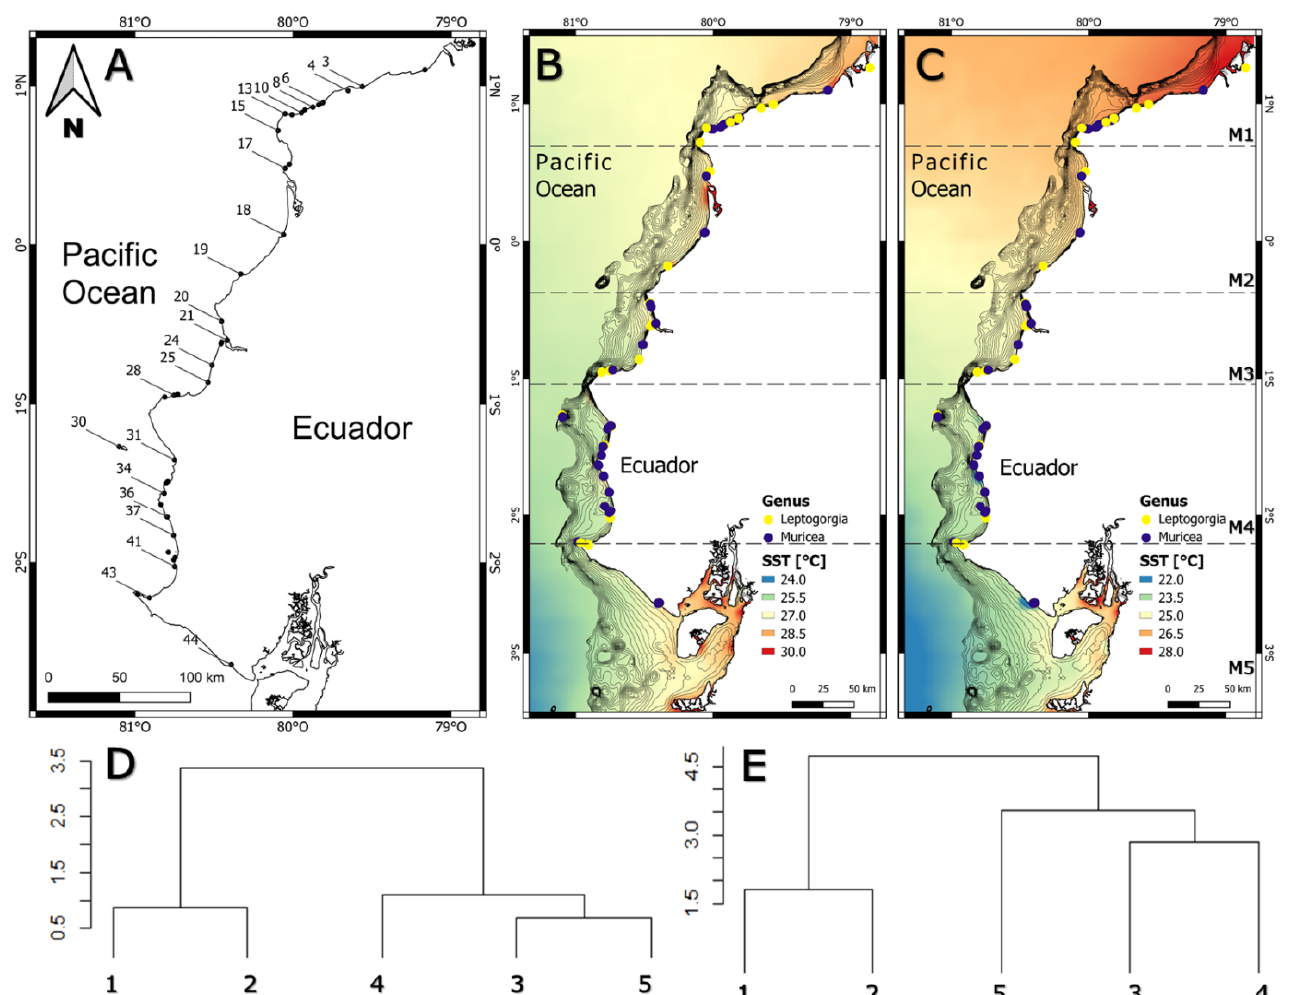
Figure 1. ( A ) Map of the Ecuadorian continental coast showing the 44 octocoral samples sites with black dots, including the Marine Protected Areas located in four coastal provinces of Ecuador. Sea Surface Temperature (SST) is in Celsius degrees (°C), and bathymetry maps are represented in a color scale from colder (blue) to hotter (red) temperature variations during both weather seasons. ( B ) Wet season (December–May). ( C ) Dry season (June–November). ( D ) SST Cluster dendrogram determined by macrozones (1–5). ( E ) General Cluster dendrogram determined with all variables (SST, CHL-a, and PAR) by macrozones (1–5). The values represent the similarities between each macrozone.